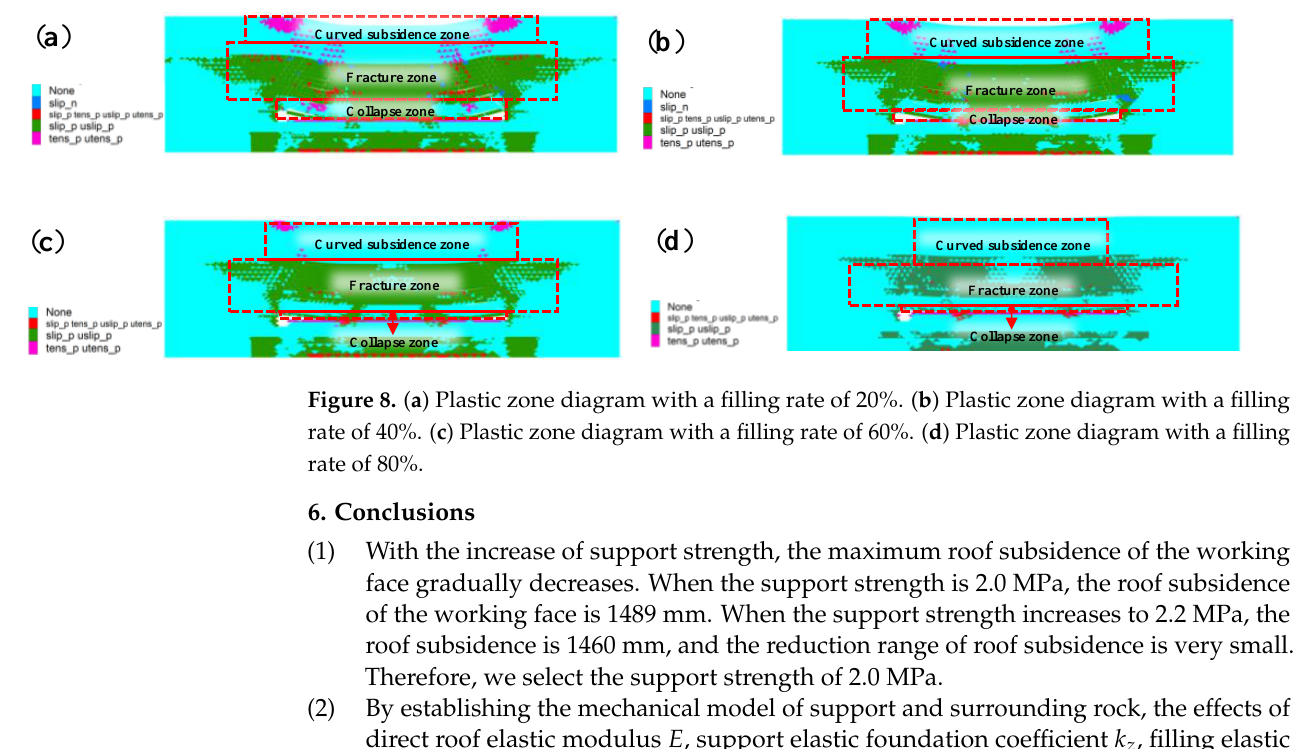
Figure 7. ( a ) Stress nephogram with a filling rate of 20%. ( b ) Stress nephogram with a filling rate of 40%. ( c ) Stress nephogram with a filling rate of 60%. ( d ) Stress nephogram with a filling rate of 80%. It can be seen from Figure 8 that when the filling rate is 20%, 40%, 60%, and 80%, the tensile failure degree of the overlying rock layer gradually decreases. The development height of fracture zone also gradually decreases, the bending subsidence zone above the fracture zone decreases with the increase of the filling rate of the goaf, and the deformation of the bending subsidence zone above the fracture zone also gradually decreases. When the filling rate is 20% and 40%, an obvious three-zone structure can be seen. When the filling rate reaches 60% and 80%, the filling body occupies the collapsed space of the original overburden, so a certain degree of rock stratum control is achieved. The filling effect is better when the filling rate is 80%.